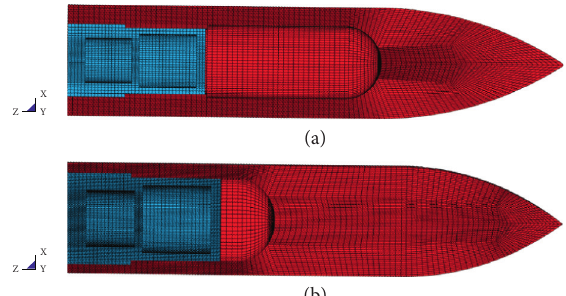
Figure 7: Finite element models of the projectiles (including the deceleration measurement device): (a) prototype projectile; (b) nonproportional scaling projectile.